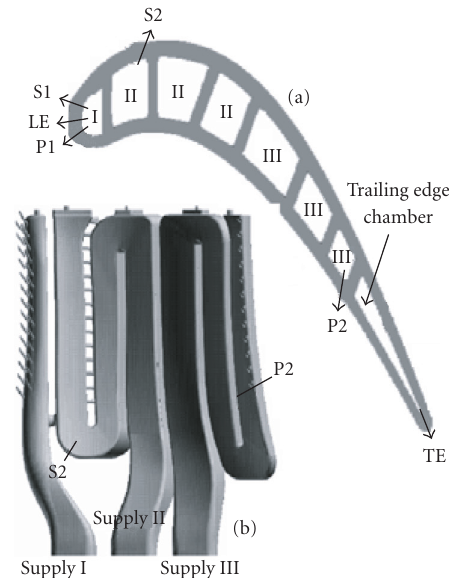
Figure 7: Film-cooled test blade: (a) mid-section of test configura- tion, (b) internal cooling system (without trailing edge chamber).